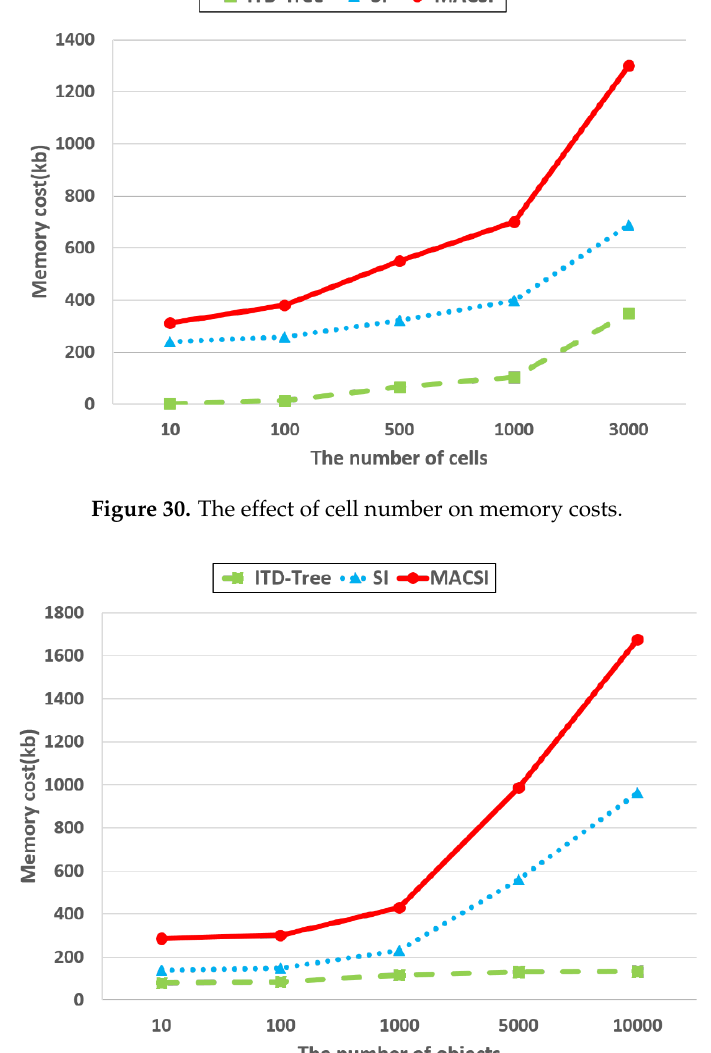
Figure 31. The effect of object number on memory costs.